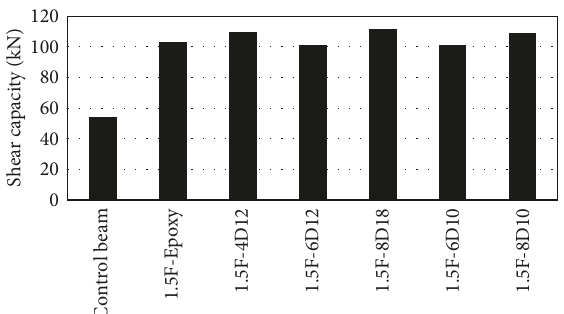
Figure 9: Shear enhancement of beams with various connection